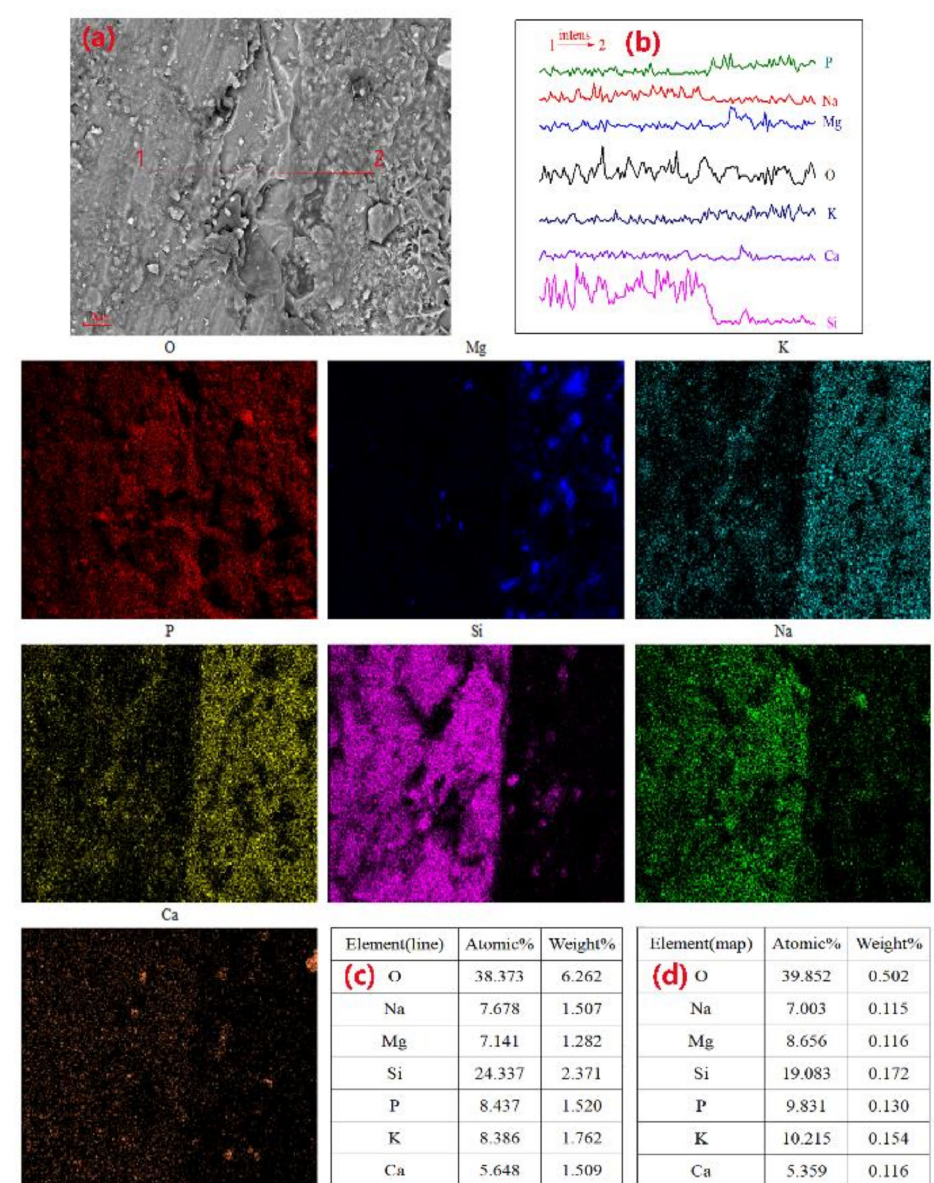
Figure 14. SEM images and element maps along lines 1–2 of the MKPC pastes cured after 7 days: M/P ratio = 3:1 and 40 wt.% content of glass fragments, ( a ) SEM image; ( b ) Intensity of each element distribution along line 1-2; ( c ) EDS elemental distribution along line 1-2; ( d ) EDS elemental